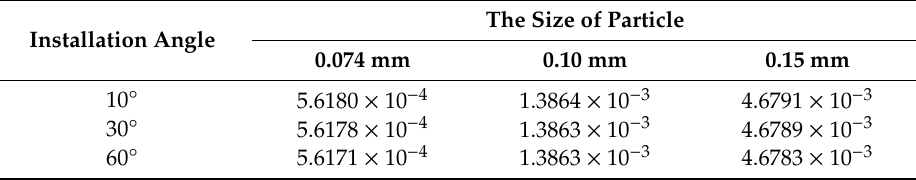
Table 7. Radial forces(N) with different mounting angles and different particle sizes.